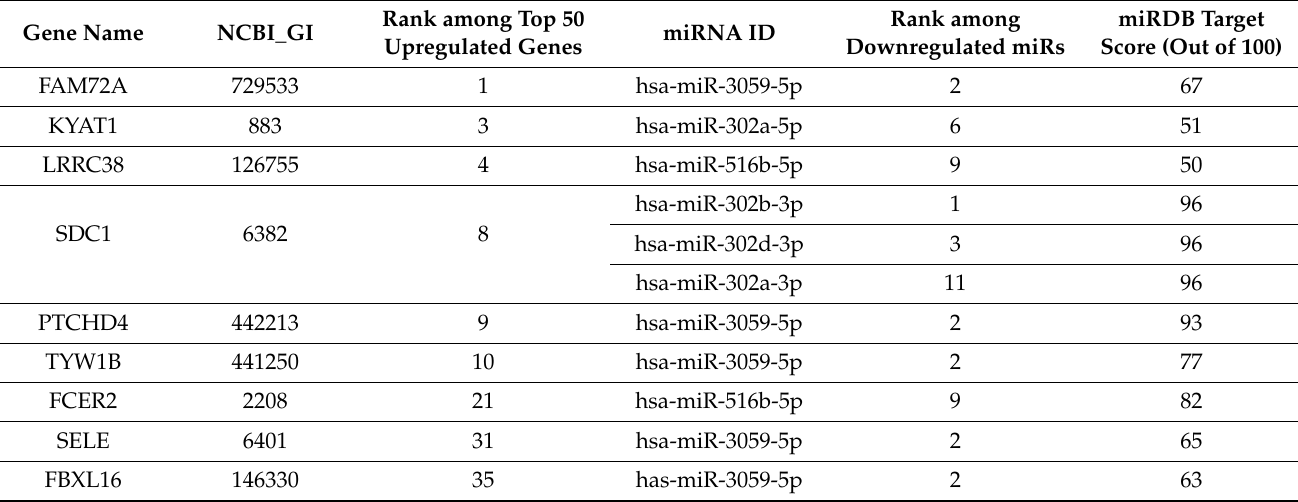
Table 3. Overlapping genes between predicted targets of top 11 downregulated miRs and top 50 positively enriched genes in